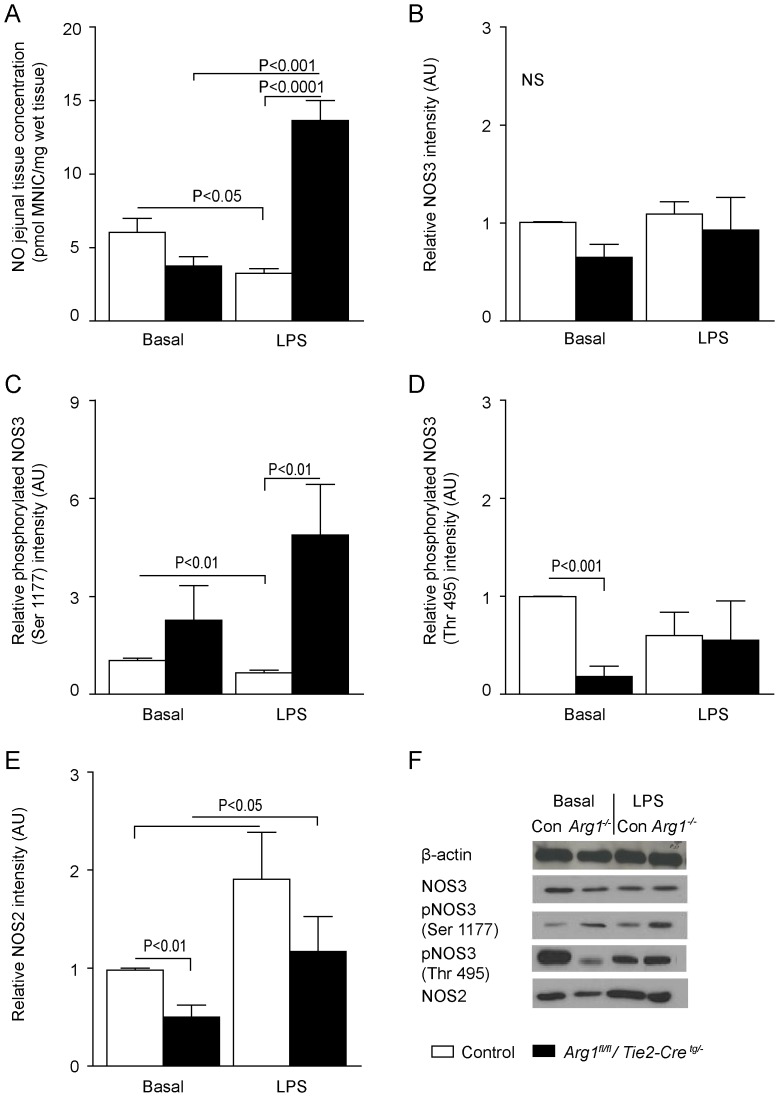
Jejunal NO production and NOS3 activity in control and Arg1fl/fl/Tie2-Cretg/− mice.(A) In the jejunum, LPS treatment decreased in vivo NO production (measured as pmol mono-nitrosyl-iron complexes (MNIC)/mg wet tissue weight) in control mice to ∼50% (Basal vs. LPS, P<0.05; n = 5), whereas it increased NO production ∼3-fold in Arg1fl/fl/Tie2-Cretg/− (Basal vs. LPS; P<0.001, n = 5). (B) Jejunal NOS3 protein concentration did not differ between basal and LPS-treated control or Arg1fl/fl/Tie2-Cretg/− mice. (C) The degree of phosphorylation of NOS3 protein on Ser1177 decreased upon LPS treatment in control mice (P<0.01), but tended to increase in Arg1fl/fl/Tie2-Cretg/− mice, so that the degree of jejunal NOS phosphorylation in LPS-treated Arg1fl/fl/Tie2-Cretg/− mice was ∼5-fold higher than in control mice (p<0.01). (D) The degree of phosphorylation of NOS3 protein on Thr495 was significantly decreased during basal conditions in Arg1fl/fl/Tie2-Cretg/− mice. (E) LPS treatment increased NOS2 protein concentration ∼2-fold in control and Arg1fl/fl/Tie2-Cretg/− mice. NOS2 protein content was normalized with β-actin. (F) Representative Western blots of β-actin, NOS3, phosphorylated NOS3 (Ser 1177), phosphorylated eNOS (Thr495) and NOS2 (bottom) are shown. In all graphs, protein content was normalized with β-actin. Arg1fl/fl/Tie2-Cretg/− mice are described as Arg1-/- in the legend above the lanes.